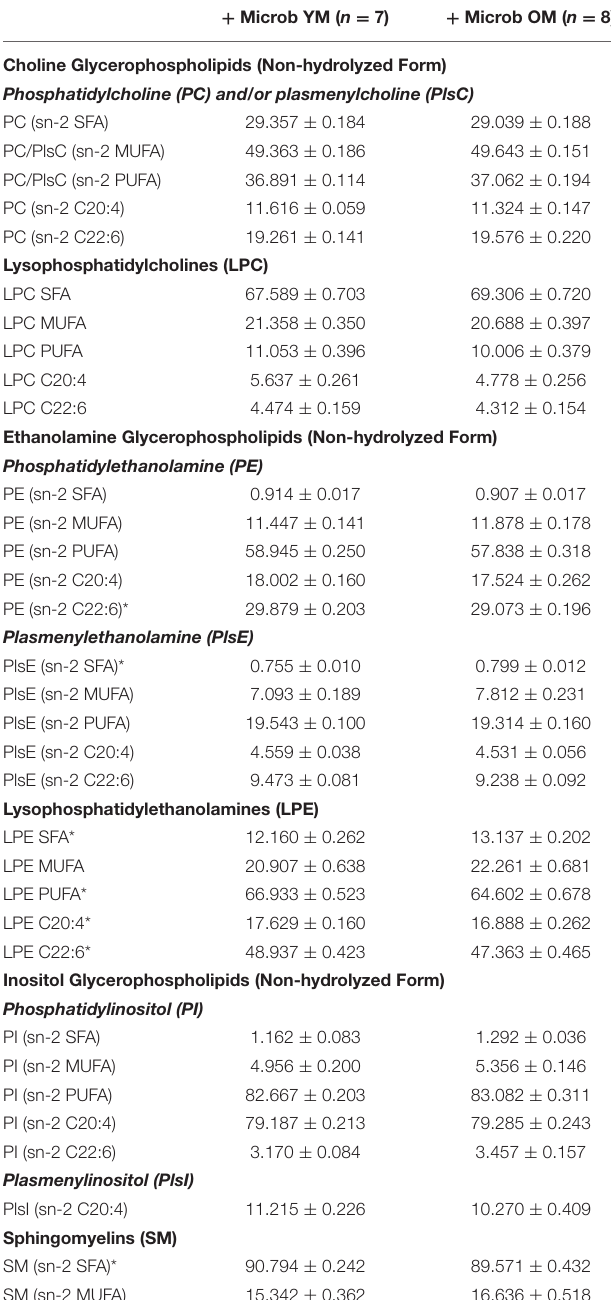
TABLE 1 | Relative amounts of lipid species in the cortex depending on the lipid class and the family of fatty acids esterified at the sn-2